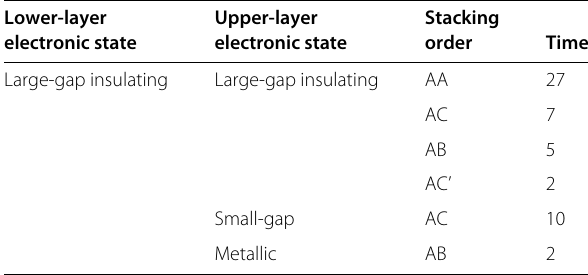
Table 1 Summary of different stacking orders observed in bulk 1 T -TaS 2 . Taken from ref.